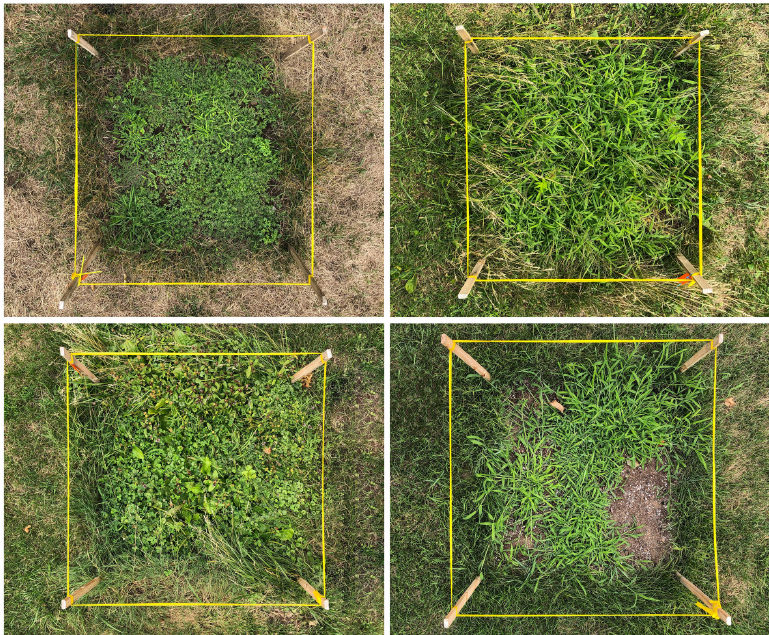
Figure 9: Lawn (Re)Disturbance Laboratory plots as seen from above, summer 2018. Counterclockwise from top left: plot 1 (Rensselaer Polytechnic Institute, Sage Avenue and 9th Street); plot 4 (Rensselaer Polytechnic Institute, Nason dormitory lawn); plot 5 (Rensselaer Polytechnic Institute, Detroit Avenue and Georgian Terrace); plot 8 (privately owned lot, North Central Troy, Ingalls Avenue and River Street).